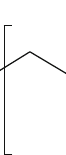
Figure 60: (a, b) Time-resolved size distribution (projected area) of the cyclic swelling ( pH = 7 ) and deswelling ( pH = 4 ) of poly(methacrylic anhydride-co-ethylene glycol dimethacrylate) (P(MAA − EGDMA)) hydrogel microcapsules with 98 mol % acid content. Droplines represent time of pH change. (c) Selected bright- fi eld microscopy images of the P(MAA − EGMDA) microcapsules during swelling and deswelling at the indicated time points in plot (b). All scale bars are 200 μ m [161].